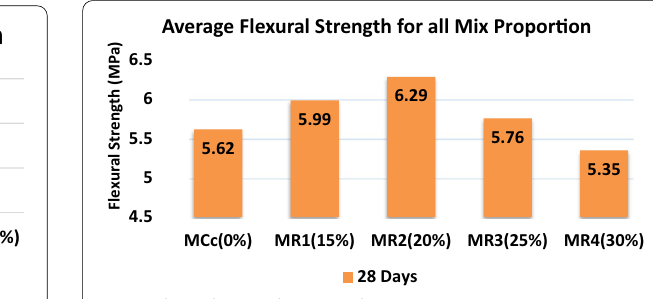
Fig. 6 Split tensile strength test